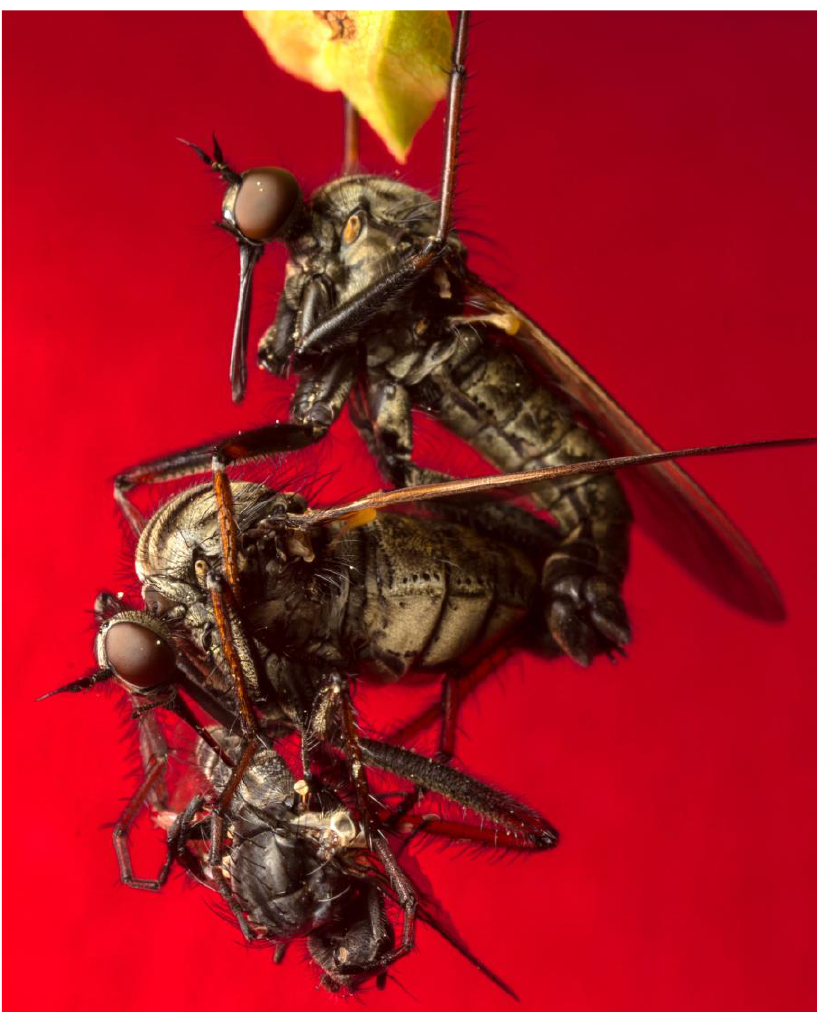
Figure 2. Mating Empis tessellata ; the pair lands on a substrate and the male supports the feeding female during copulation. Top: male; centre: female; bottom: nuptial gift. Note that the nuptial gift here is another empidine, Rhamphomyia crassisrostris . Reprinted with permission from Tom Houslay.